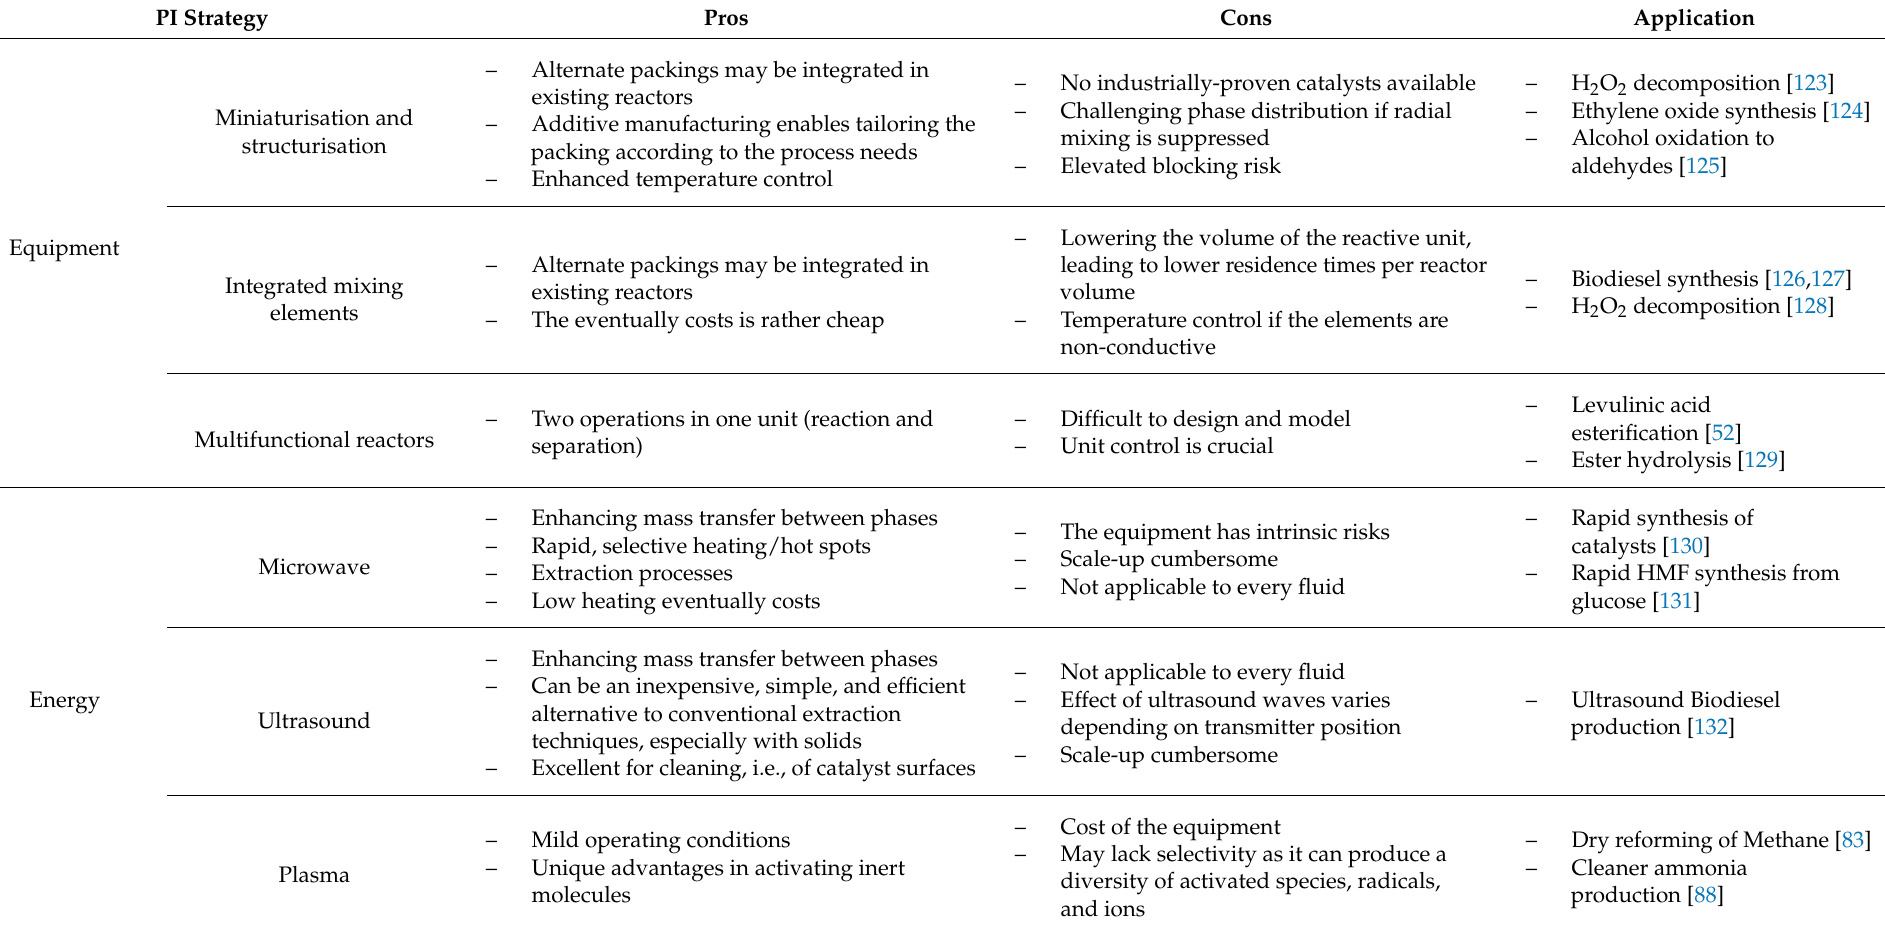
Table 1. Main benefits and drawbacks of different PI strategies and potential application